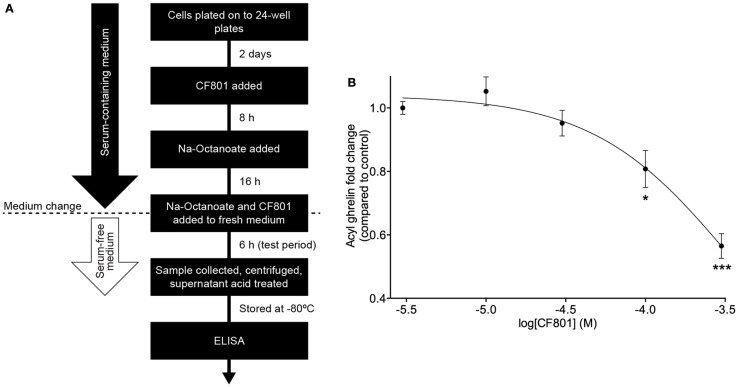
CF801 inhibits acyl ghrelin secretion from SG-1 cells following 24 h of incubation. (A) depicts the in vitro assay design. (B) shows Acyl ghrelin concentration in the culture medium collected during a 6 h test period following 24 h incubation at the indicated concentrations of CF801. All values are expressed as mean ± SEM. *p < 0.05, ***p < 0.001 significant difference in acyl ghrelin concentrations with CF801 treatment when compared to untreated control (n = 6 wells).